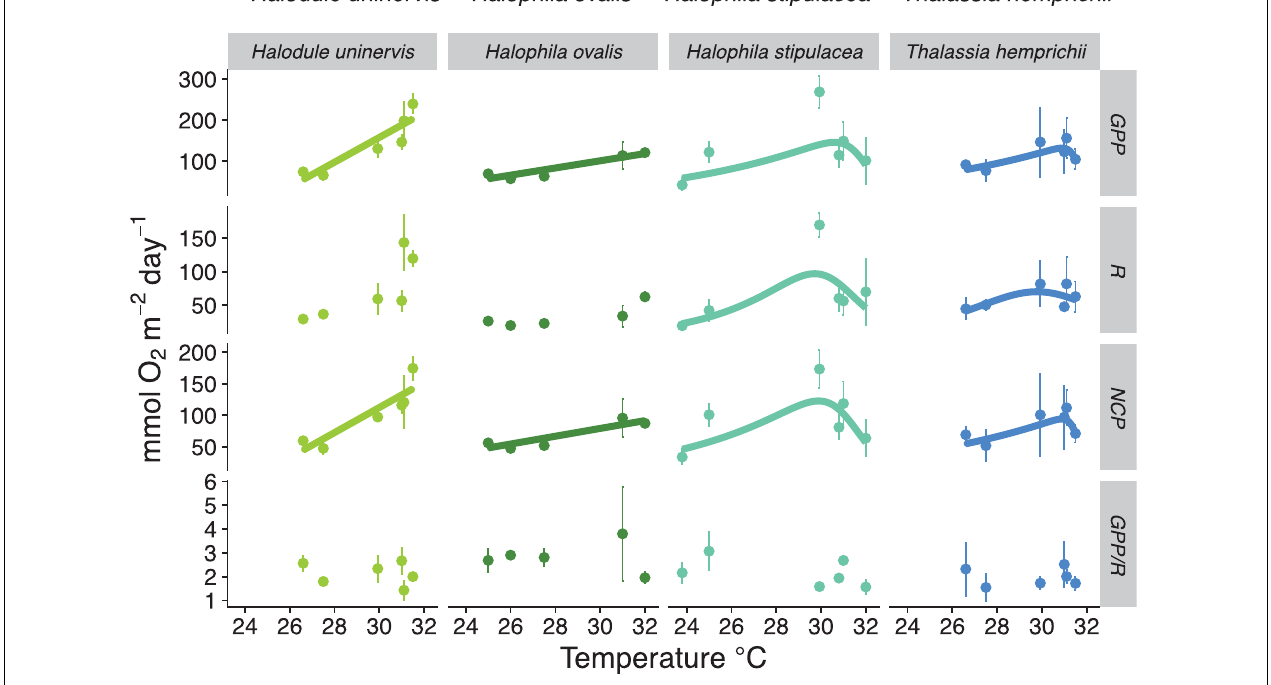
FIGURE 3 | Relationship between the temperature and the metabolic rates (GPP, R, and NCP in mmol O 2 m − 2 d − 1 ) and GPP/R of seagrass meadows in the Red Sea. Colors indicate the dominant seagrass species on the meadows ( Halodule uninervis in light green, Halophila ovalis in dark green, Halophila stipulacea in light blue, and Thalassia hemprichii in indigo blue). Solid dots indicate the mean ± SD per location. Significant relationships are indicated with a solid line. Data collected in summer and winter are included.